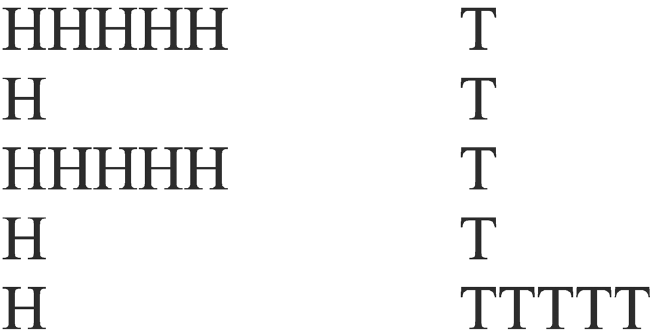
Fig 1. Two Navon letters. To the left: The large letter F made up of small letters H. To the right: The large letter L made up of small letters T.